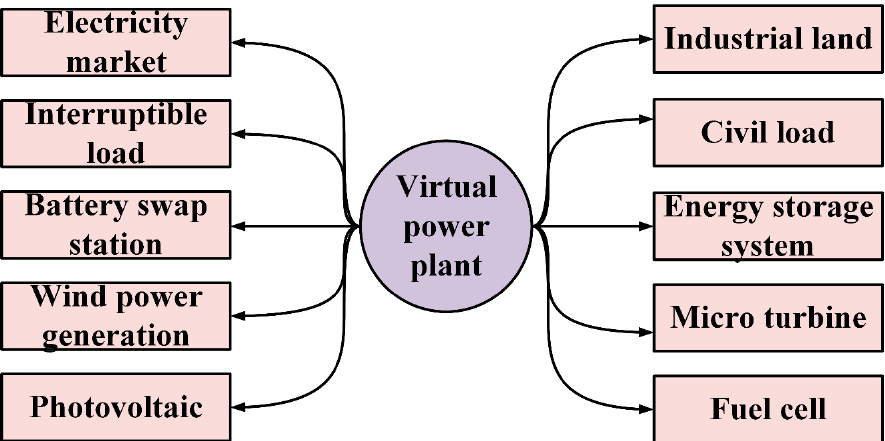
Figure 9. Basic components of virtual power plant. VPP is formed by combining a group of distributed energy resources (DERs). It also consists of different types of load. It has similar characteristics of conventional generating units in case of total capacity [73].